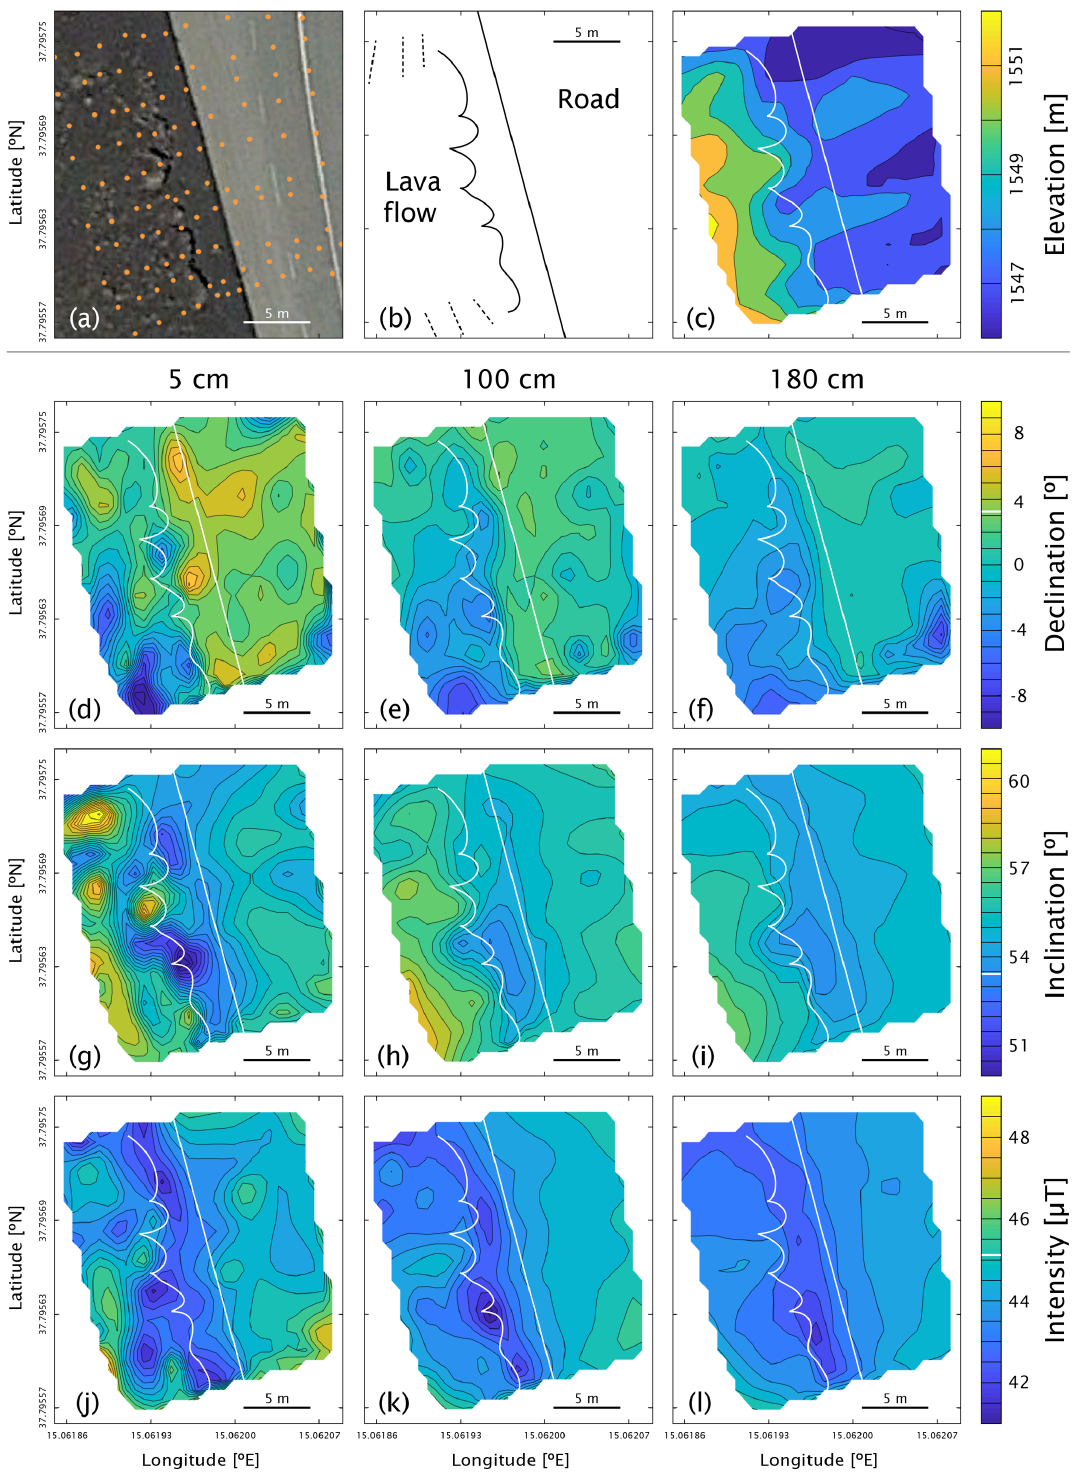
Figure 3. Experimental results as acquired on a roadcut in the 2002 flow of Mt. Etna. The GPS locations of the measurements are orange dots on a Google Earth image (a) . The road, rock face (wavy solid line), and shallower north and south slopes of the lava flow (dashed lines) are sketched (b) ; the rock face and edge of the road are indicated in white in the other panels. The elevation was determined by the GPS sensor (c) . The declinations (d–f) , inclinations (g–i) , and intensities (j–l) were measured at 5 (d, g, j) , 100 (e, h, k) , and 180cm (f, i, l) above the ground. For ease of comparison between panels with the same parameter the color schemes and contour lines are kept constant. The declination, inclination, and intensity as predicted by the International Geomagnetic Reference Field (IGRF, April 2018) are indicated as solid white lines in the scale